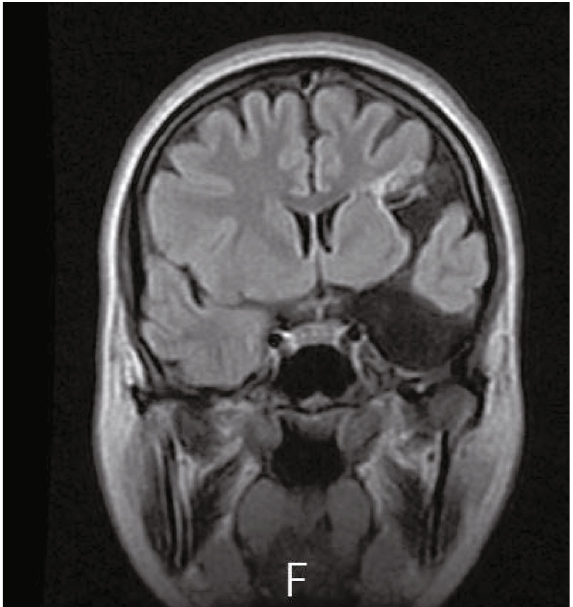
Figure 3: Coronal T1-weighted view showing the communication between the arachnoid cyst and the porencephalic cyst trough the Sylvian fi ssure, which makes this combination of conditions unique and